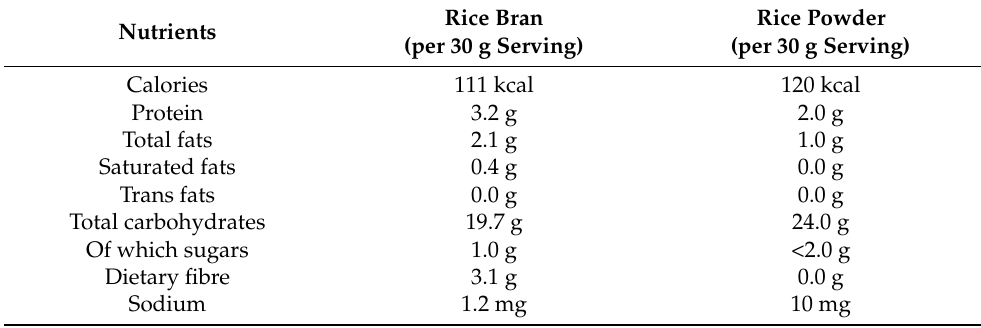
Table 1. Nutrition information of the rice bran and rice powder used in this